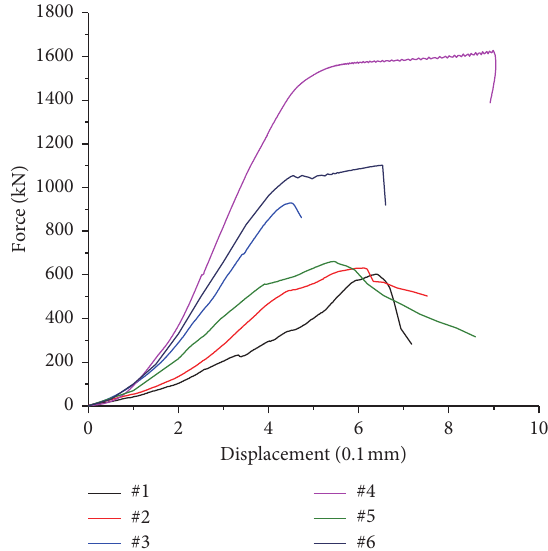
Figure 11: Load-displacement curve of turntable specimens (di- rectional arrangement, concrete-filled steel tube, and stirrup